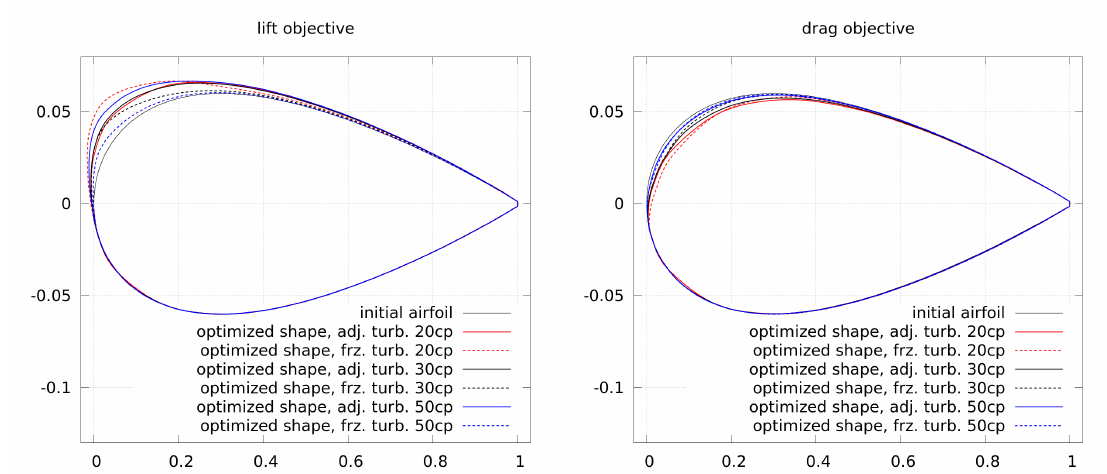
Figure 13. Airfoil shapes using adjoint and frozen turbulence for the lift and drag objective with NACA 0012 at AoA = 12 ◦ . Frozen as well as adjoint turbulence are used. The number of control points is labeled as “XXcp”.